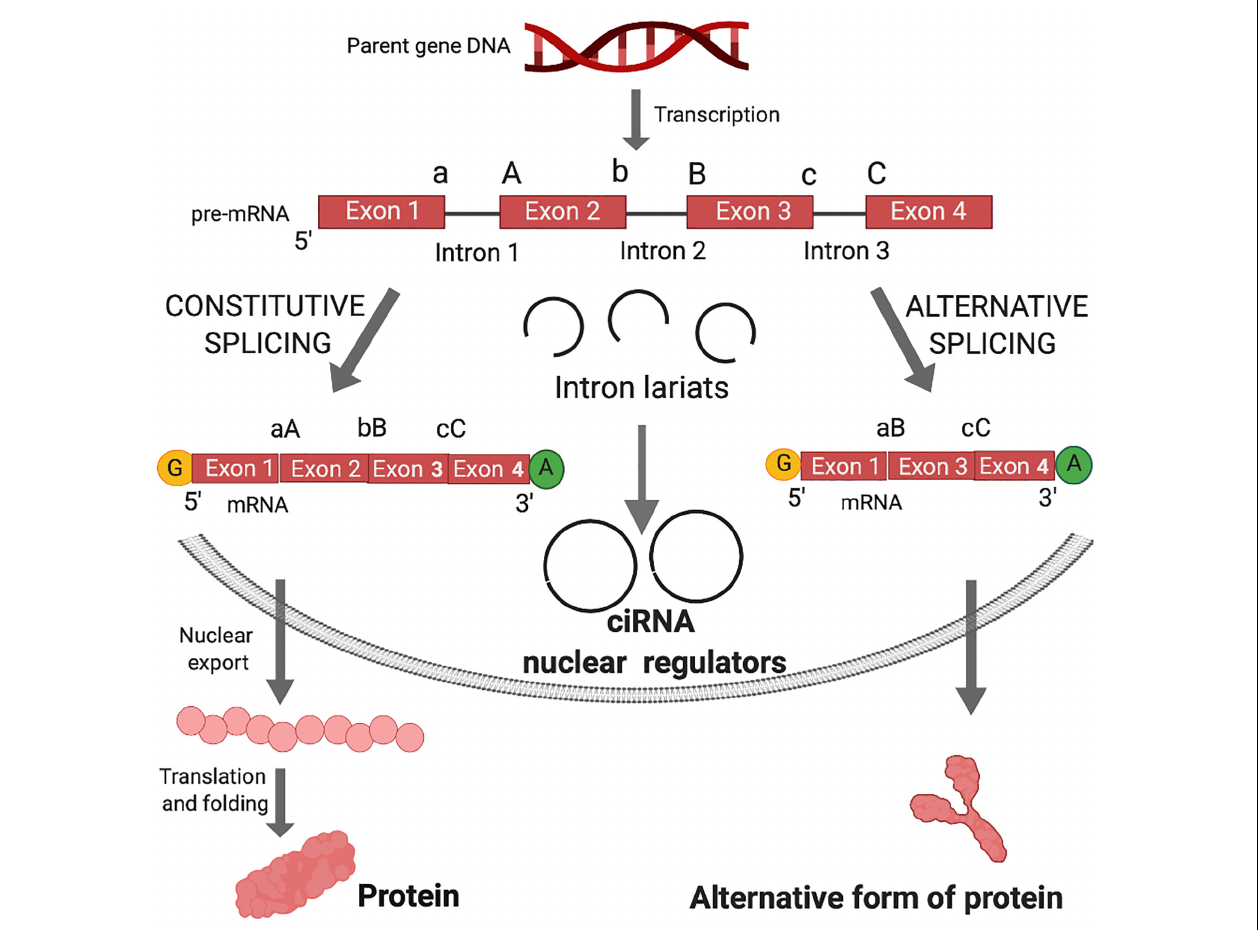
FIGURE 1 | Canonical splicing and the biogenesis of circular intronic RNA (ciRNA) and functional outcomes. Shortly after gene transcription, the nascent RNA (pre-mRNA) is processed by the addition of the 7-methyl guanosine cap (yellow G) and polyadenylate tail (green A). In the linear splicing process, introns are excised and exons are joined in a linear manner to form mRNA for translation into proteins. Exons are joined by ligation of 3 (cid:48) splice sites (a, b, or c) and 5 (cid:48) splice sites (A, B, or C). The intron sequences are excised from the pre-mRNA creating intron lariats. Lariats can be destroyed in the process of debranching after excision from the pre-mRNA. In case of debranching failure, ligation of lariats can generate circular intronic RNA (ciRNA). ciRNA are retained in the nucleus and can act as nuclear regulators of parental gene transcription. Alternative splicing occurs when an exon in the pre-mRNA is skipped, resulting in diverse mRNA isoforms that may be either degraded via nonsense mediated decay or undergo nuclear transport, translation and folding into an alternative form of